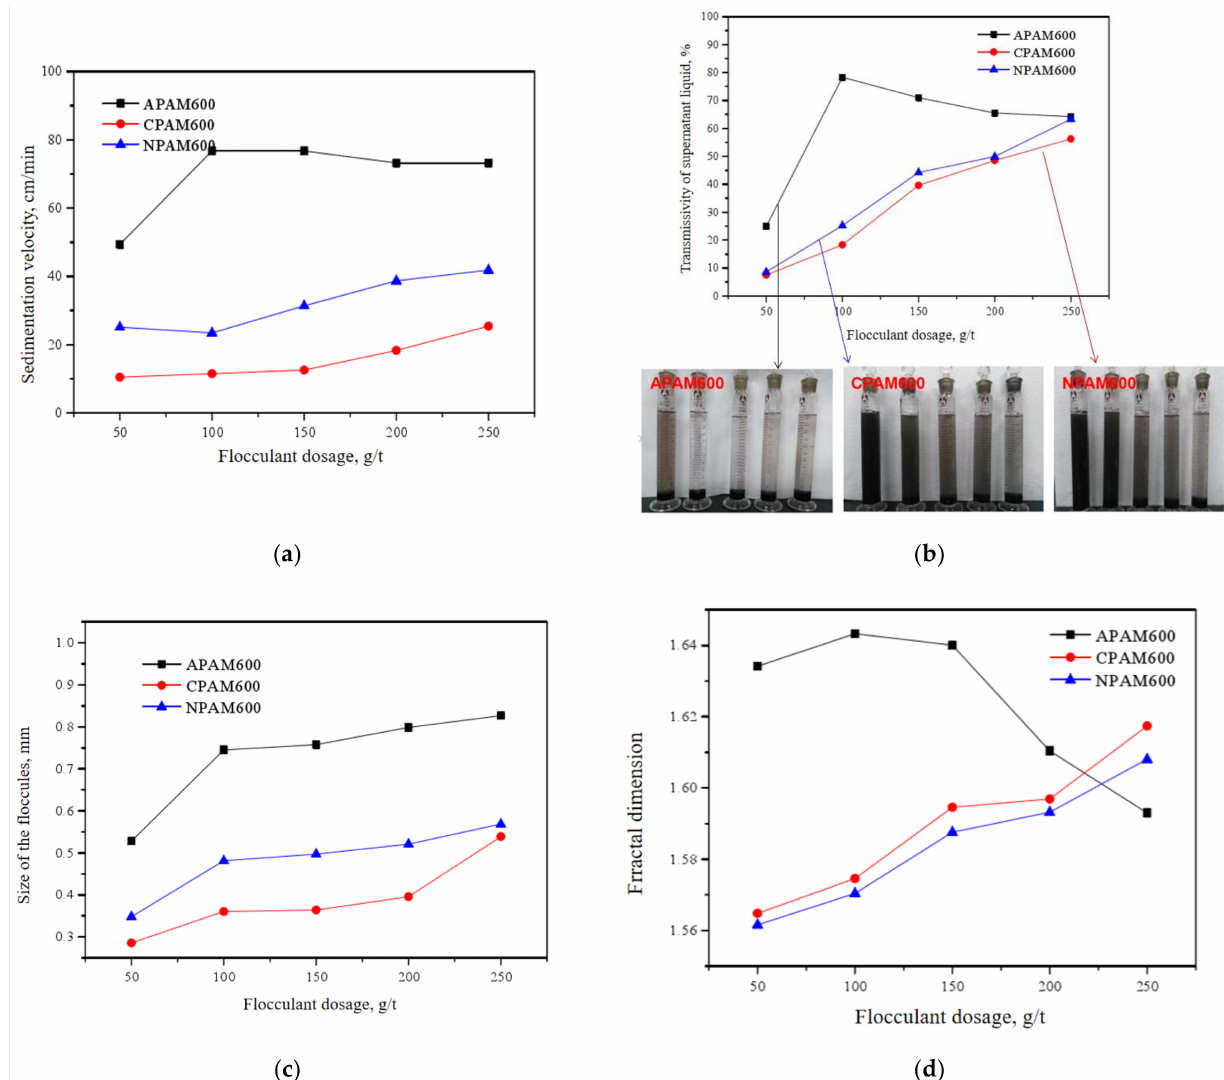
Figure 10. Testing results of different flocculant. ( a ) Sedimentation velocity; ( b ) transmissivity of supernatant liquid; ( c ) size of the floccules; ( d ) fractal